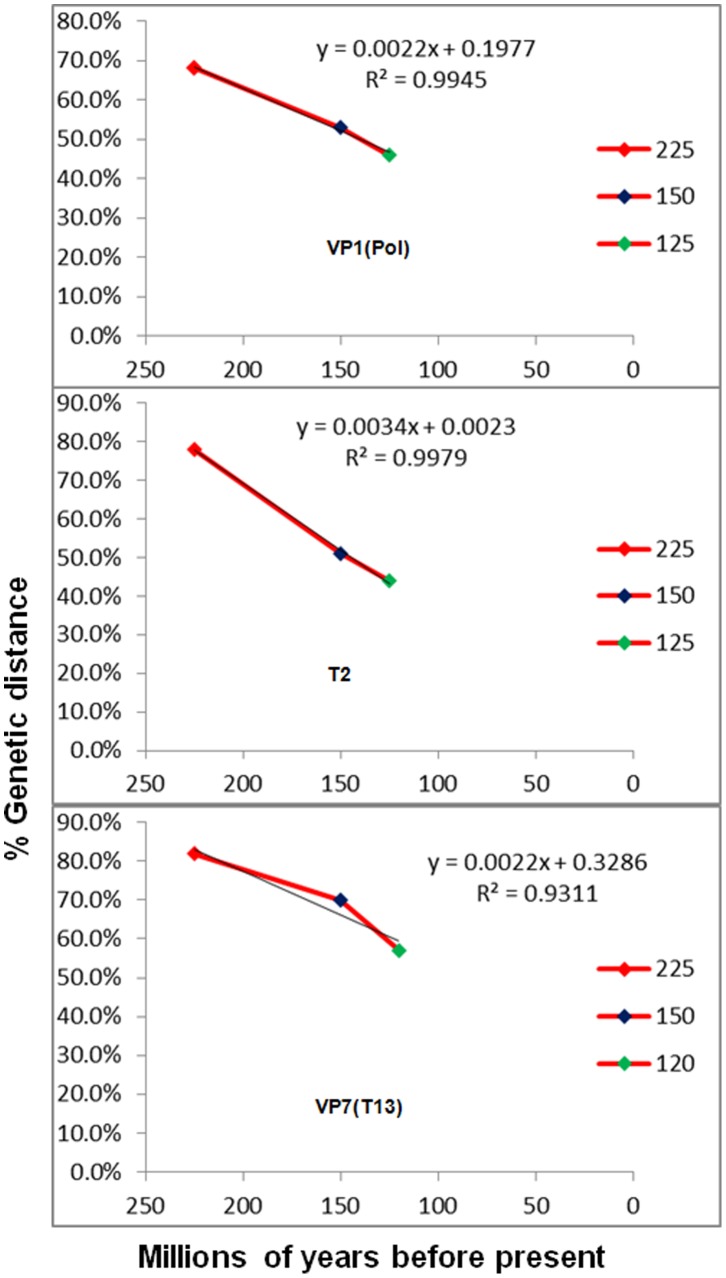
Linear relationships linking the largest genetic distances between tick-borne, mosquito-borne or Culicoides-borne orbiviruses and time of divergence for vectors.The largest genetic distance within a group of orbiviruses (tick-borne, mosquito-borne or Culicoides-borne) is plotted against the date of separation of vector groups (ticks, mosquitoes or midges). A linear relationship is depicted for both the VP1(Pol) and the T2 (correlation coefficient R2>0.99), and is less obvious in the T13 protein (R2 = 0.9311).